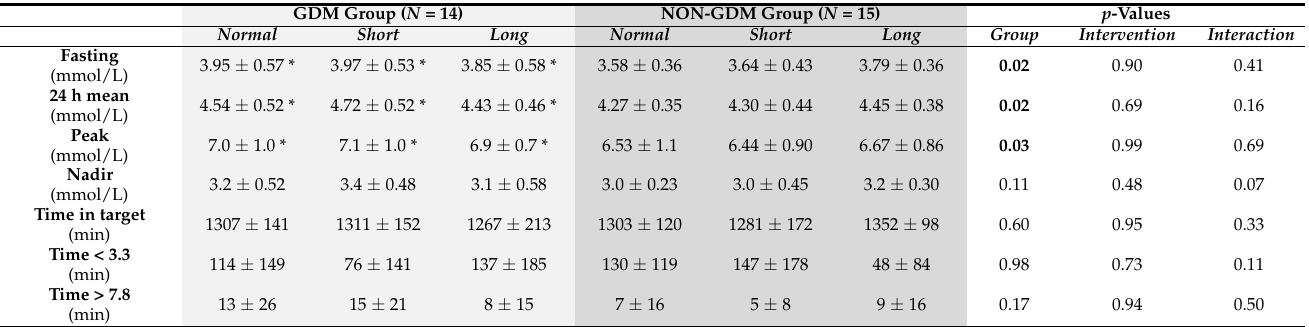
Table 2. Fasting, 24 h, peak, and nadir values and time in target, time below 3.3 mmol/L, and time above 7.8 mmol/L in women with and without GDM across three